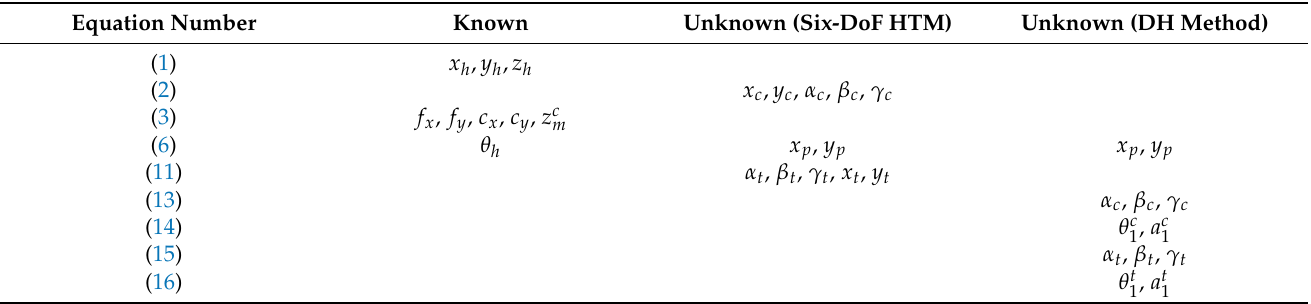
Table 1. Known and unknown (should be optimized)